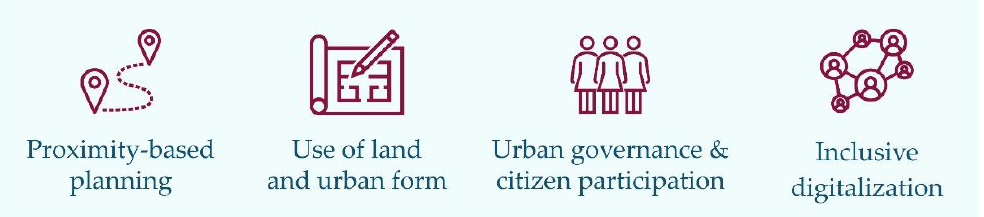
Figure 4. Emerging themes for urban planning and policymaking in the 15-minute city (authors).